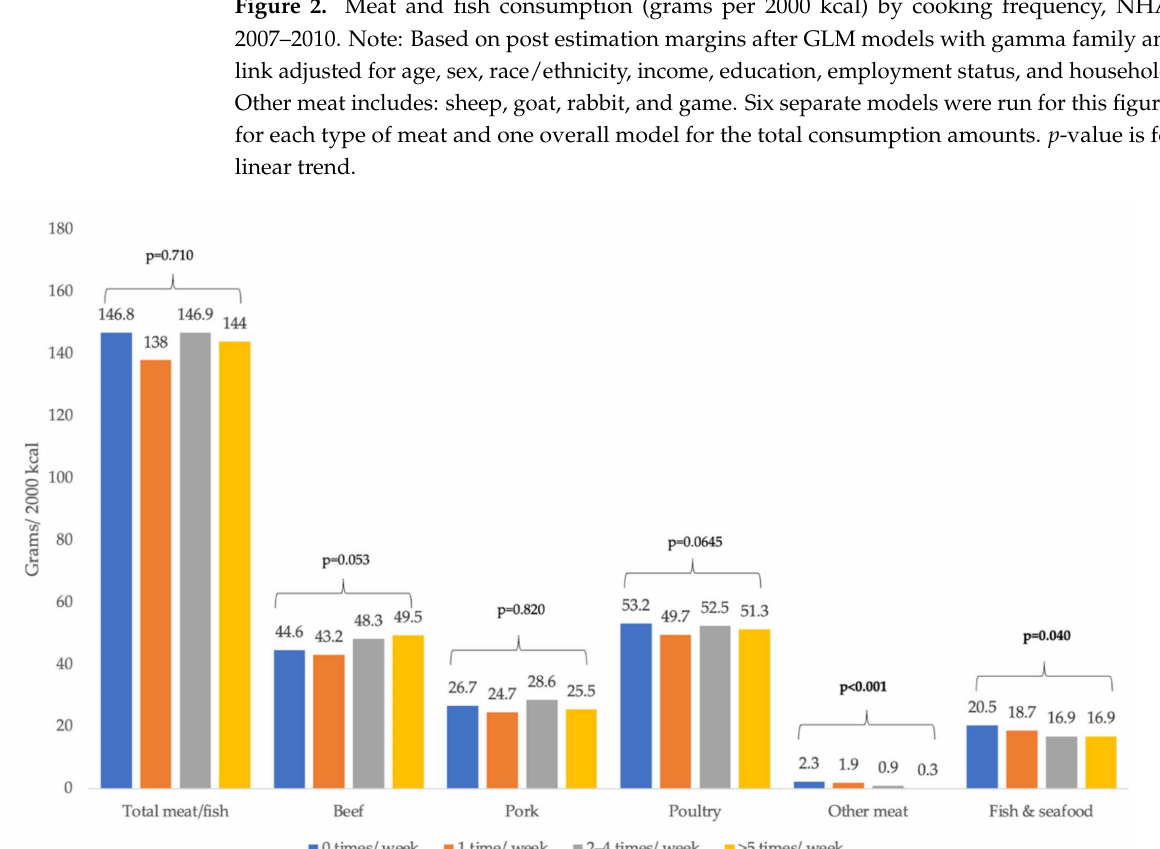
Figure 3. Meat and fish consumption (grams per 2000 kcal) by fast-food frequency, NHANES 2007–2010. Note: Based on post estimation margins after GLM models with gamma family and log link adjusted for age, sex, race/ethnicity, income, education, employment status, and household size. Other meat includes: sheep, goat, rabbit, and game. Six separate models were run for this figure, one for each type of meat and one overall model for the total consumption amounts. p -value is for the linear